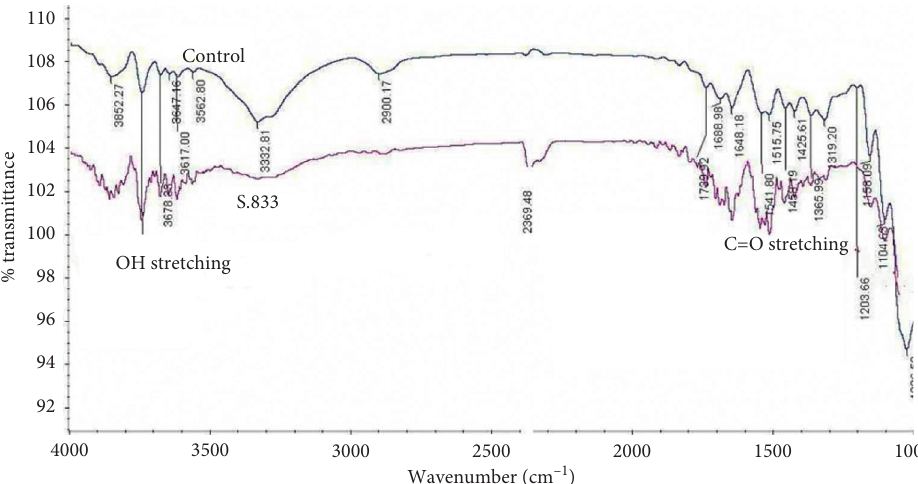
Figure 7: FTIR spectra pattern of the paper compared with a modern standard